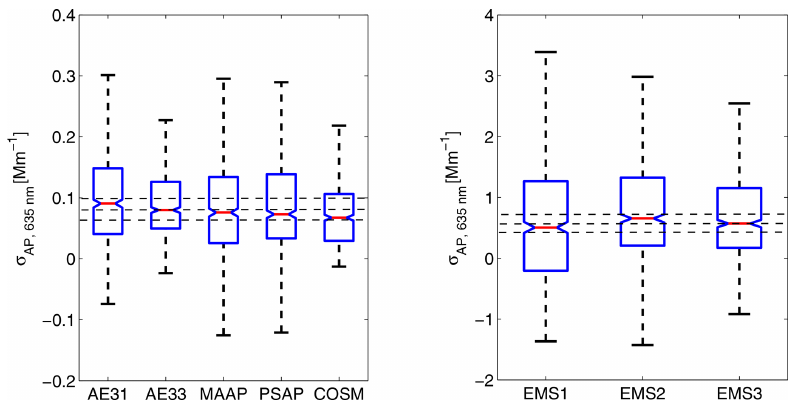
Figure 3. The vertical black lines show the range of 1h averaged absorption coefficient values measured with the eight different techniques labeled in the x axis. The red lines show the medians and the blue boxes the 25th and 75th percentiles. The horizontal dotted black lines present the overall medians ± 25%.